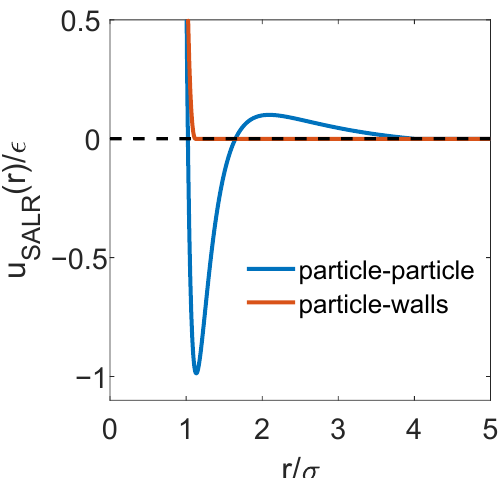
Figure 1. The Lennard-Jones plus Yukawa potential used to model the interactions between colloidal particles and the Lennard-Jones potential truncated and shifted at the energy minimum used to model the interactions between the slit walls and the